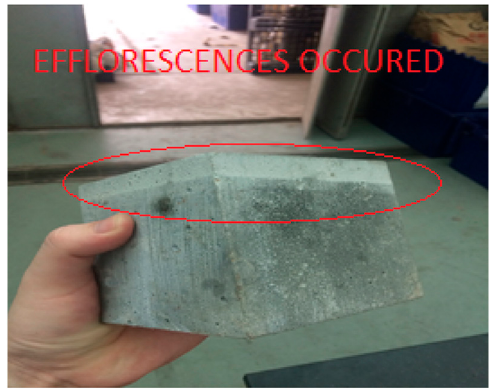
Figure 8. Calcium carbonate deposition layer on the specimen.